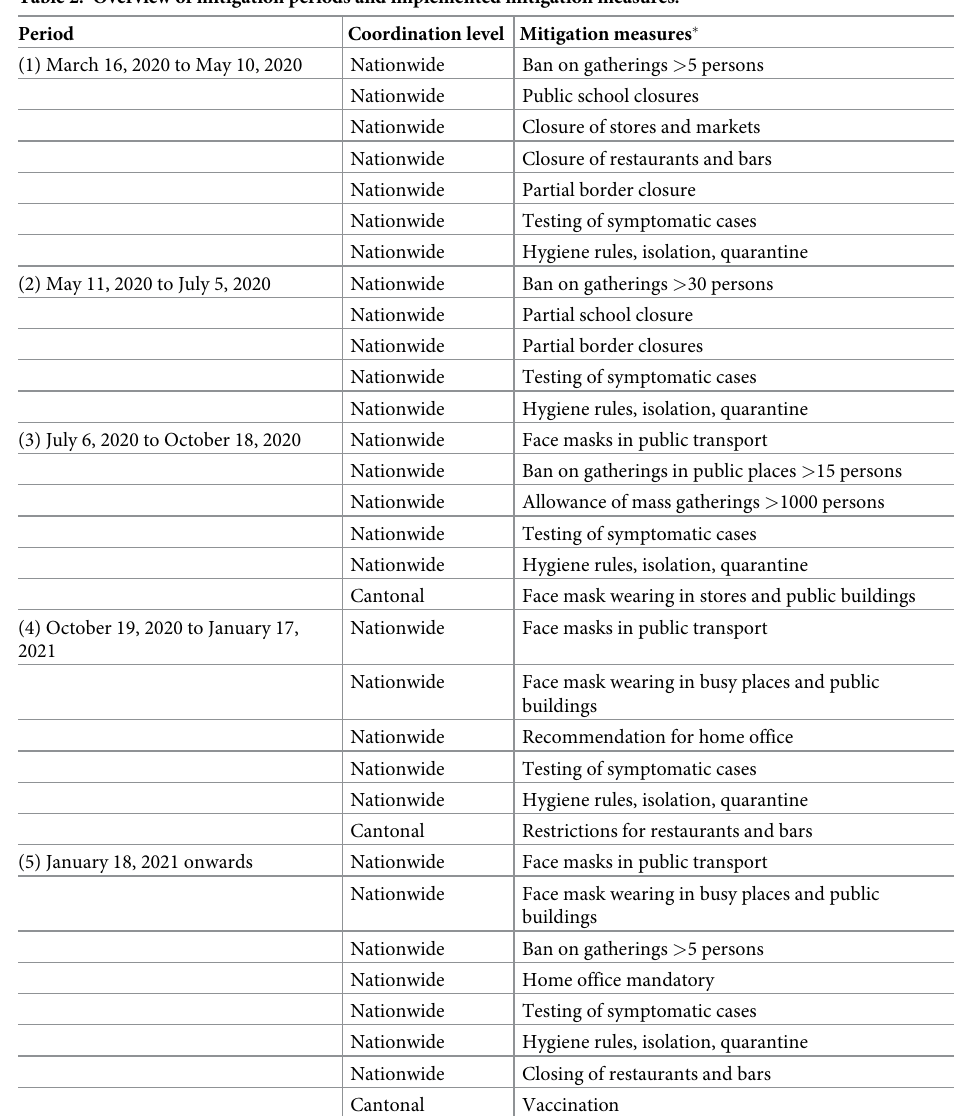
Table 2. Overview of mitigation periods and implemented mitigation measures.